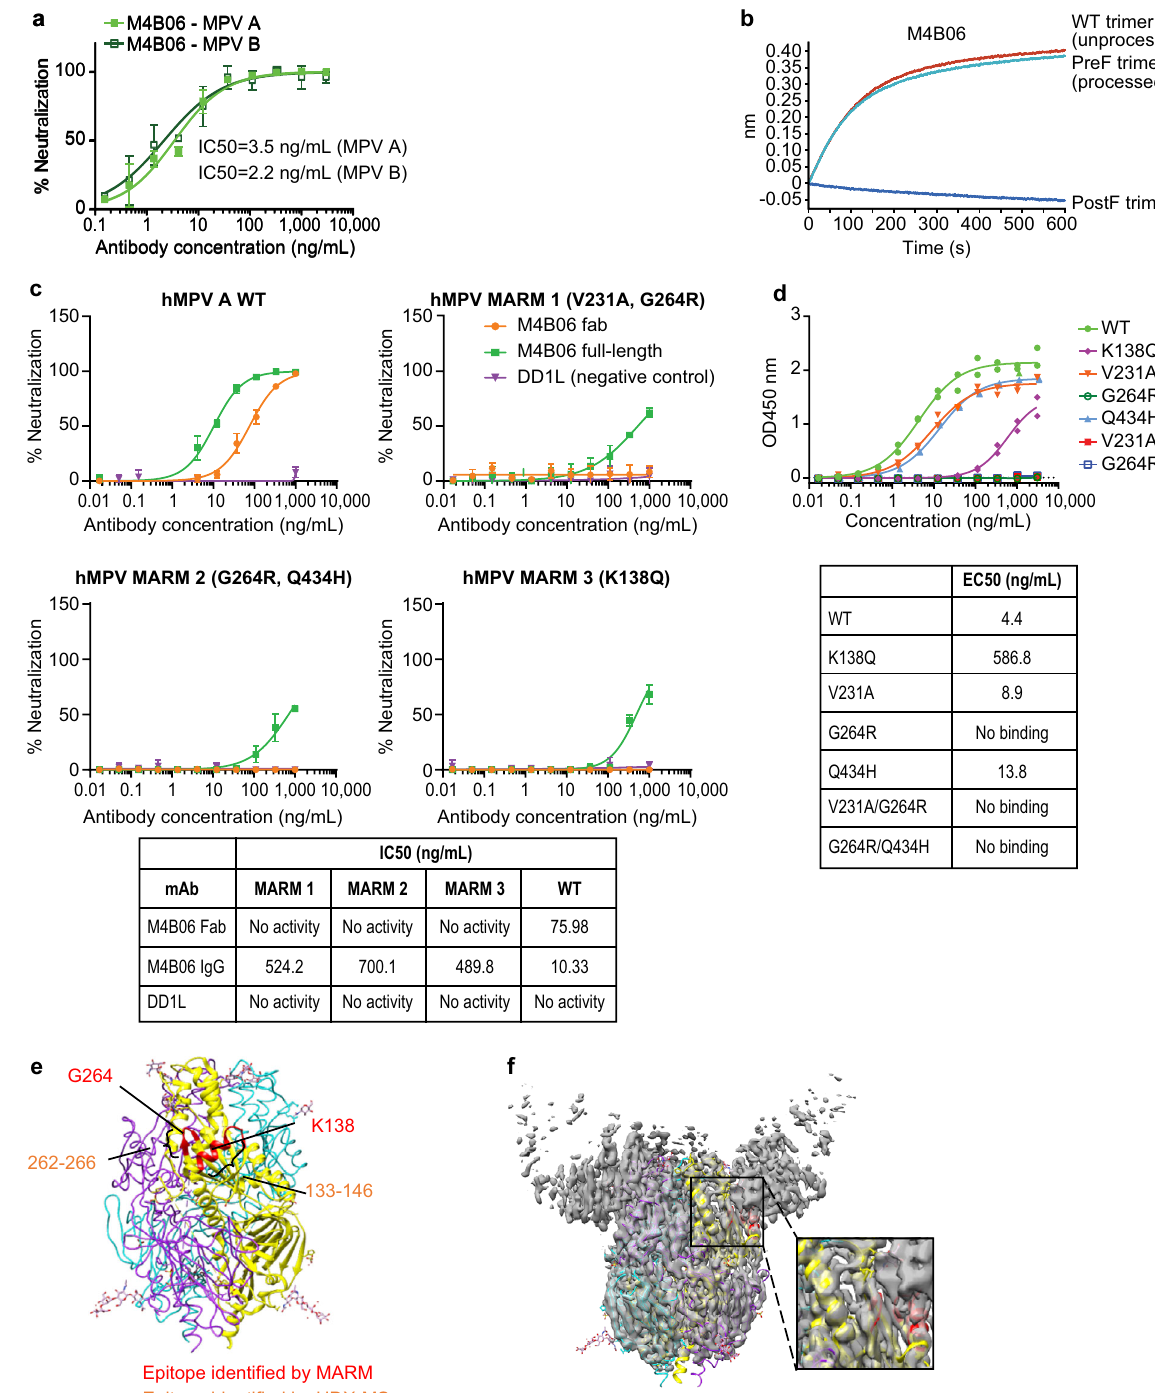
Fig. 2 Characterization of an ultra-potent neutralizing mAb M4B06. a Neutralization of M4B06 IgG to hMPV A and B strains. Data were presented as mean values ± SD of three replicates. b BLI binding of M4B06 IgG to unprocessed PreF trimer, processed PreF trimer, and PostF trimer. c Neutralization of M4B06 IgG and Fab, as well as an irrelevant control antibody (DD1L), to hMPV PreF and three types of MARM viruses. Data were presented as mean values ± SD of three replicates. d Binding of M4B06 IgG to unprocessed hMPV PreF WT and PreF carrying MARM mutants, determined by ELISA with Expi293 cell culture supernatants containing expressed antigens. Data were presented as mean values± SD of two replicates. e M4B06 epitopes identi fi ed by MARM and HDX-MS were mapped on an hMPV PreF structure, with epitope residues colored in red in the ribbon diagram. f Cryo-EM map of three M4B06 Fabs in complex with a processed PreF trimer at 3.75 Å. The hMPV PreF model with the same coloring as (E) fi t in the density. Source data are provided as a Source Data fi